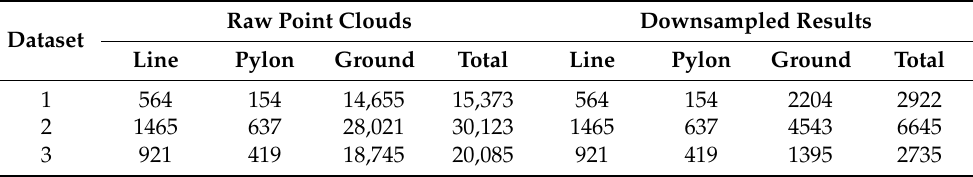
Figure 15. Training data from different perspectives after preprocessing (red, green and blue points represent wire, pylon, and ground points, respectively). Table 5. Comparison of the number of various targets in the original data and after